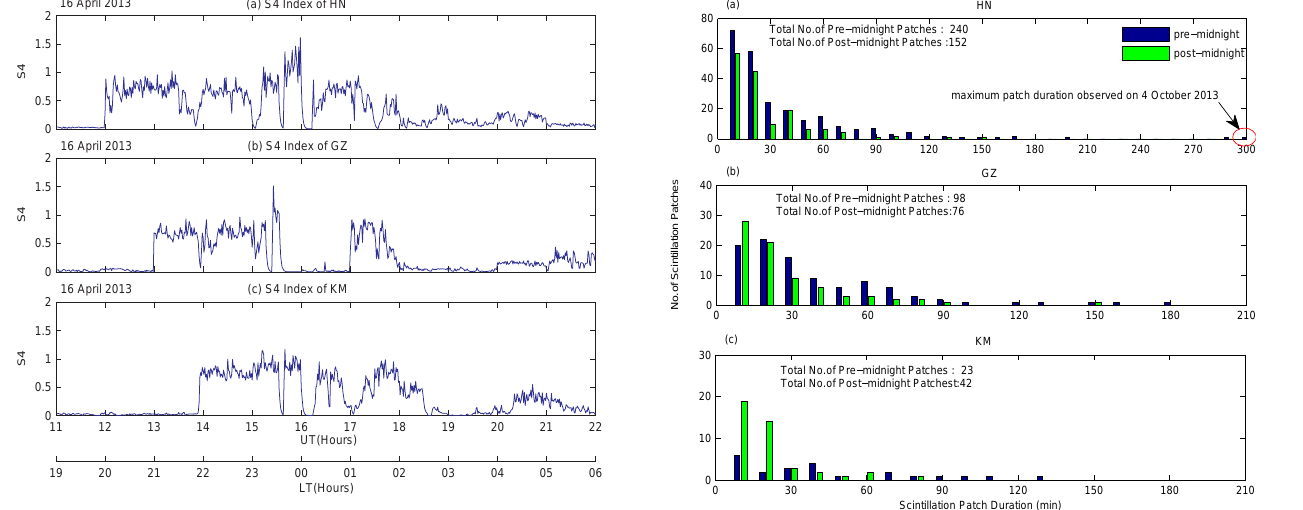
Figure 2. The distributions of the scintillation patch durations for every 10min interval observed at the three locations in 2013. The total number of the scintillation patches is indicated in each of the